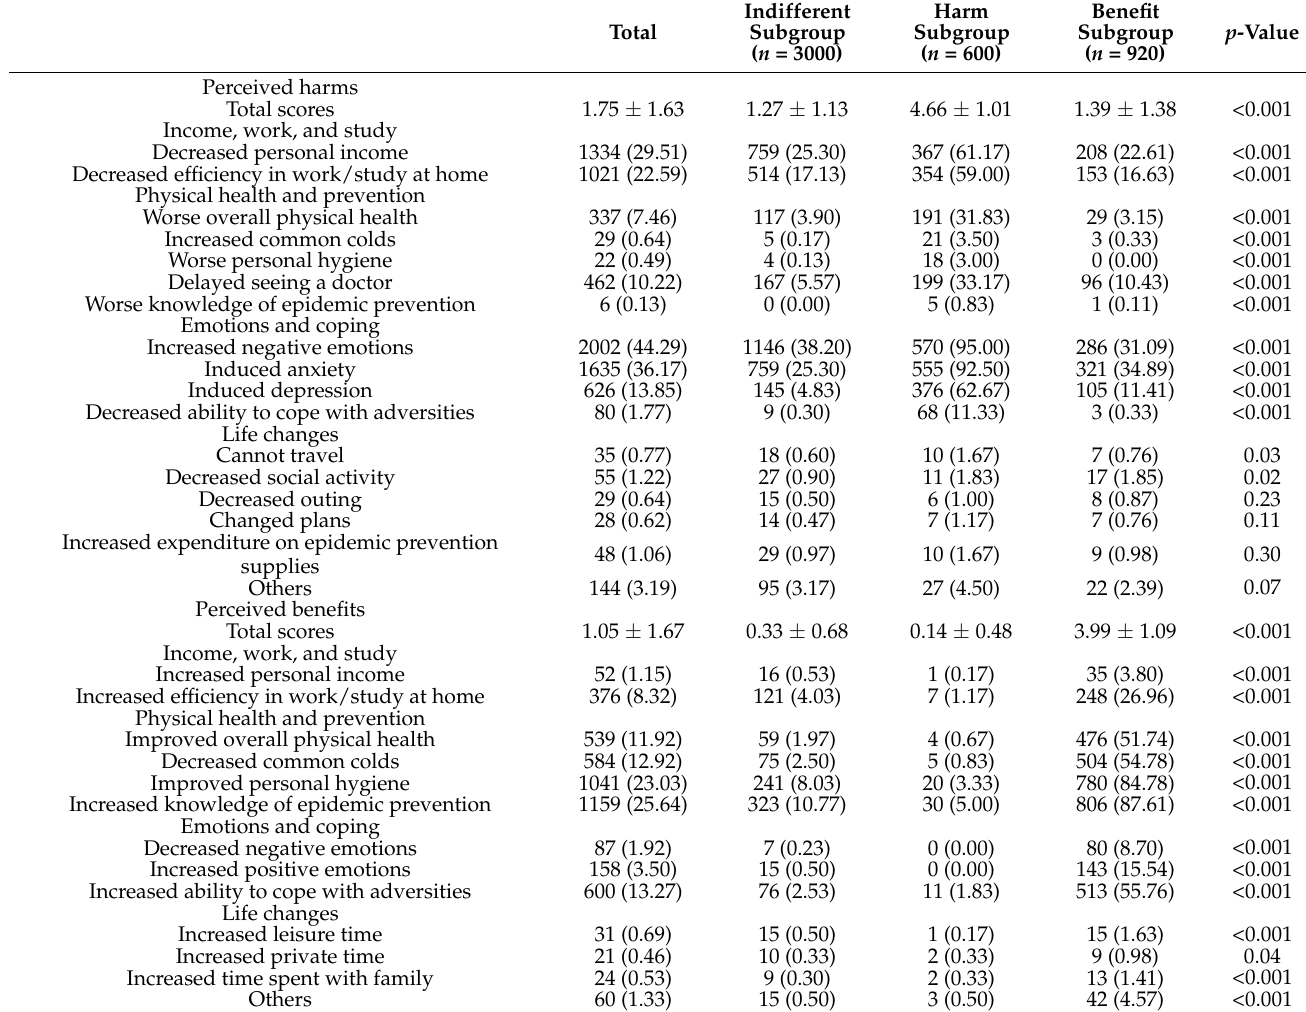
Table 3. Profile characteristics of participants’ responses on each item of perceived harms and benefits in the total sample and each subgroup, unweighted, n (%) or Mean ± Standard deviation (N = 4520).